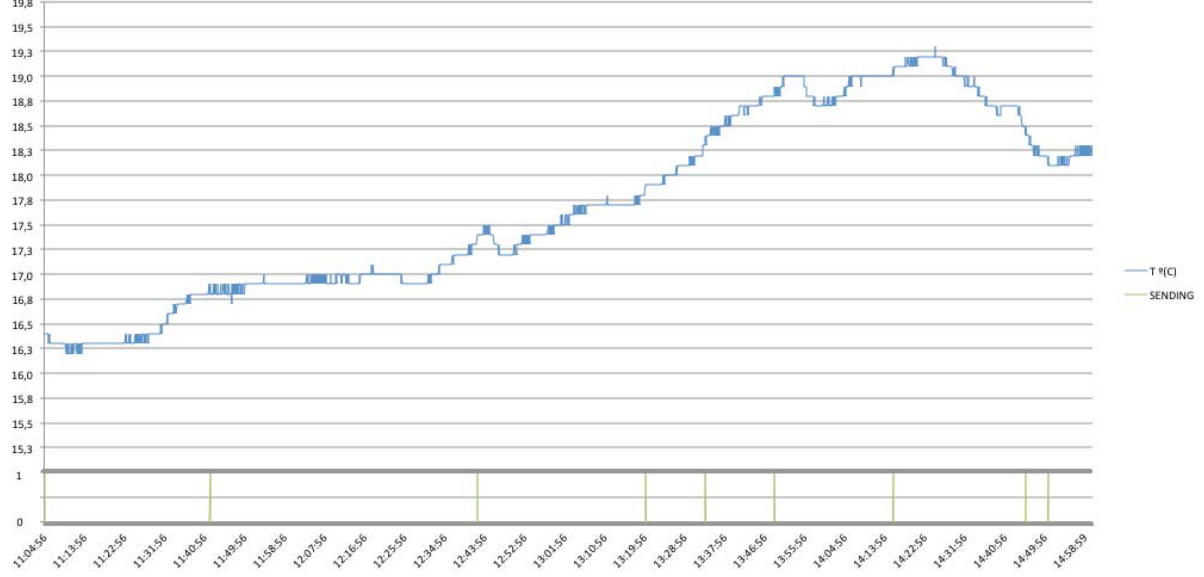
Figure 32. Notifications with Observe Conditional, Step option set to 0.5